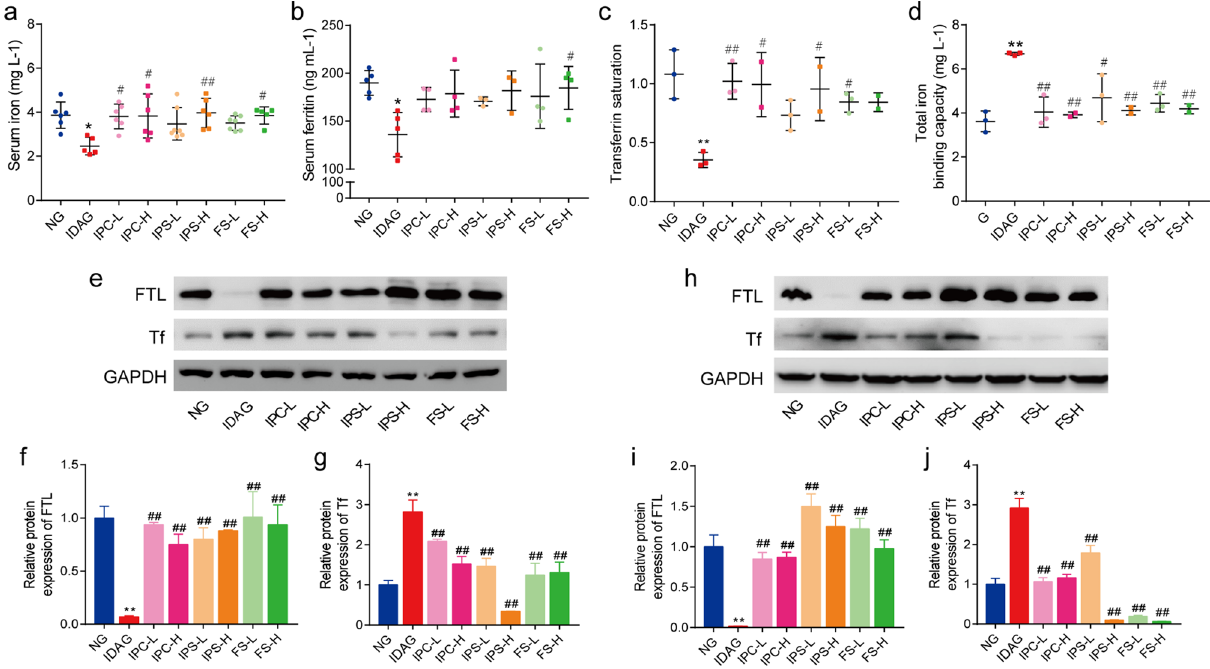
Figure 3. Iron related indexes of maternal rats after iron supplement treatment. The serum of maternal rats was collected and tested. ( a ) SI. ( b ) SF. ( c ) TS. ( d ) TIBC. Data are presented as mean ± SD ( n = 6). Western blot analysis for FTL and Tf in liver ( e – g ) and spleen ( h – j ). The quantification of western blotting was provided in supplementary material. Data of Western blot analysis (mean ± SD) are expressed as the ratio of the relative contents between the value from IDA group and NG group and six iron treatment groups (n = 3). The relative contents of target proteins were quantified using the ratio between the optical density (OD) of target protein and the amount of the housekeeping protein GAPDH. SI serum iron, SF serum ferritin, TS transferrin saturation, TIBC total iron binding capacity, FTL ferritin light chain, Tf transferrin. * p < 0.05, ** p < 0.01, compared with NG, # p < 0.05, ## p < 0.01, compared with IDAG. One-way ANOVA followed by Tukey multiple comparison test was used for comparison among 8 different